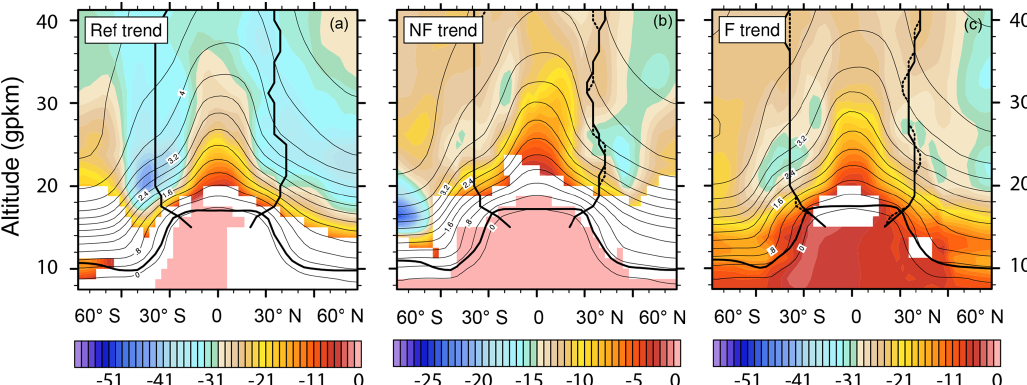
Figure 6. CMAM zonal mean AoA annual trend (days per decade) after the correction of the pressure levels trend for the Ref (a) , NF (b) and F (c) period, in colors. Only trends that exceed the 95% significance level are plotted. The mean AoA climatology of the respective period is contoured, and the tropopause and the turnaround latitudes (computed from the residual circulation field interpolated to the geopotential height corrected to the upward shift of the pressure levels) are shown by bold black lines. The turnaround latitude of the preceding period is illustrated by a dashed line.